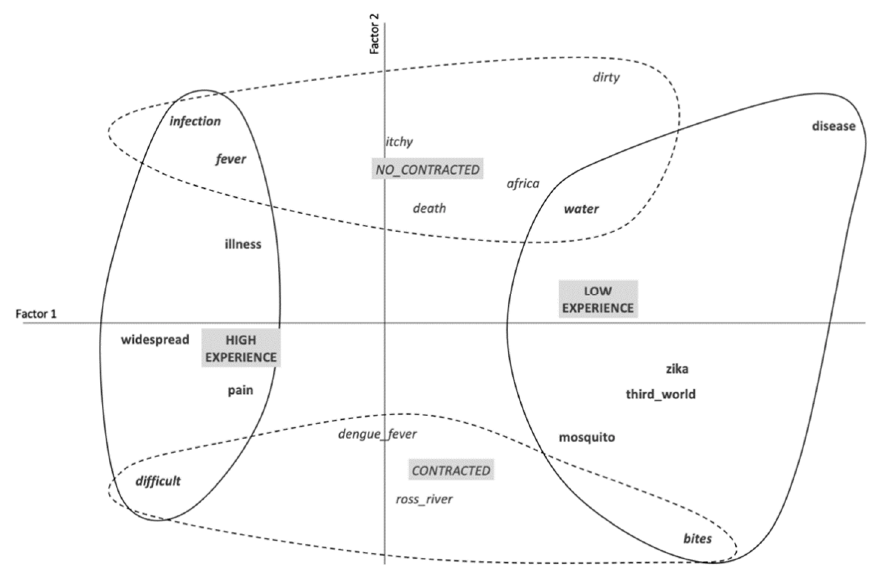
Figure 1. Graphical representation of the results obtained by means of the CFA concerning factors 1 (57.59% of inertia) and 2 (42.41% of inertia). Note 1: Grayed blocks refer to the variables. “ Variables ” contribute to the formation of factor 1; “Variables” refer to the variables which contribute to the formation of factor 2; “ Variables ” refer to the variables which contribute to the formation of both factors 1 and 2. “ Observations ” refer to the observations which contribute to the formation of factor 1; “ Observations ” refer to the observations which contribute to the formation of factor 2; “ Ob- and 2.